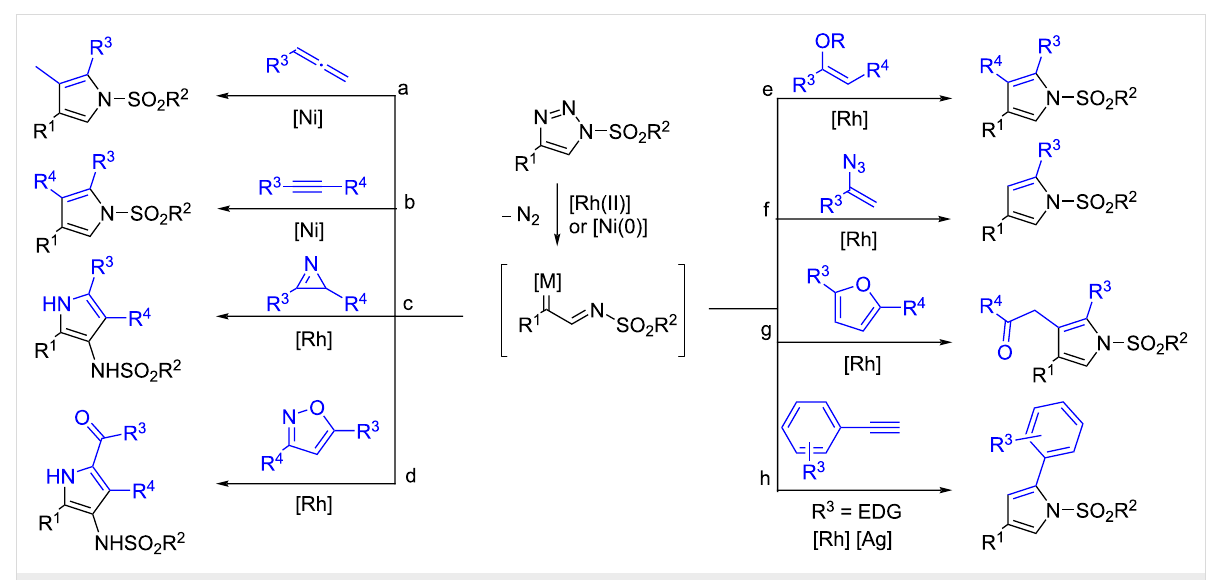
Scheme 1: Transformation of N- sulfonyl-1,2,3-triazoles to pyrroles via metal iminocarbenes.